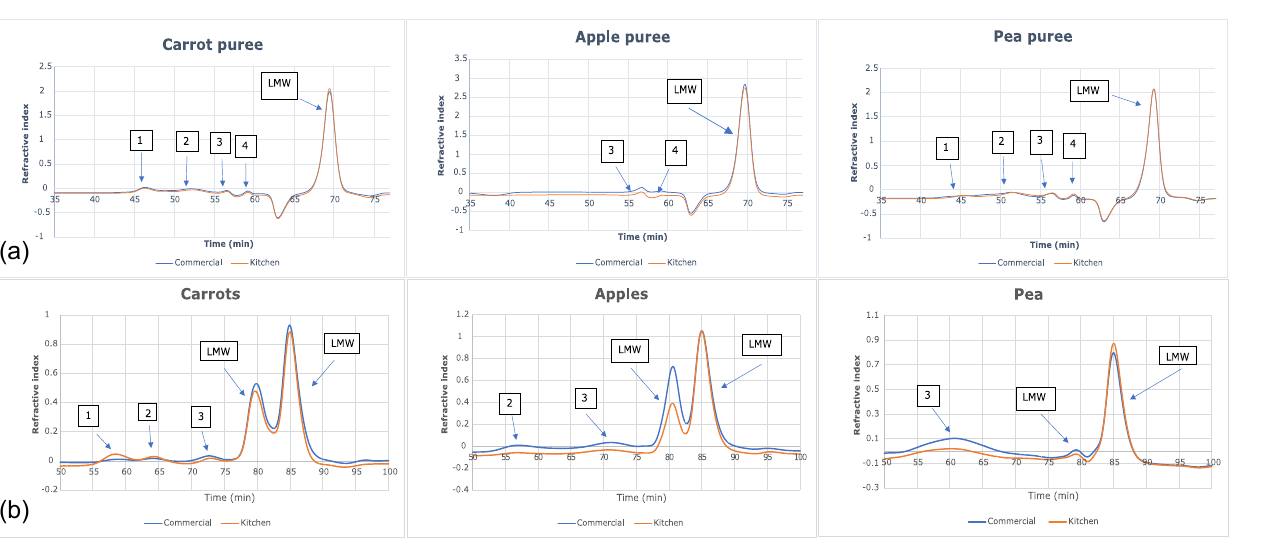
Figure 3. Size-exclusion chromatograms of ( a ) water-soluble fractions and ( b ) insoluble fractions in apple, carrot, and green pea purees.